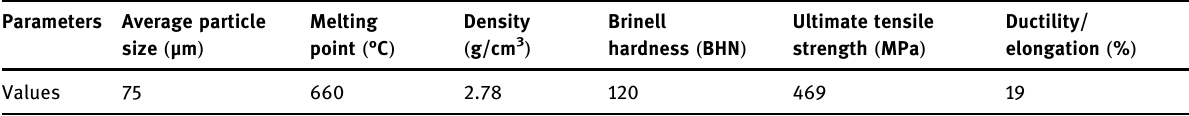
Table 3: Properties of AA2024 - T351 alloy Parameters Average